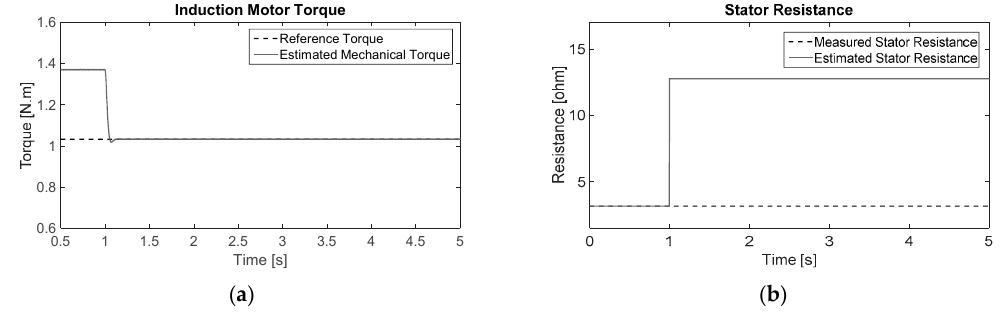
Figure 14. Alternative method to estimate the modified stator resistance (“Method 2”)—experimental results for ( a ) IM torque estimation and ( b ) IM modified stator resistance estimation.